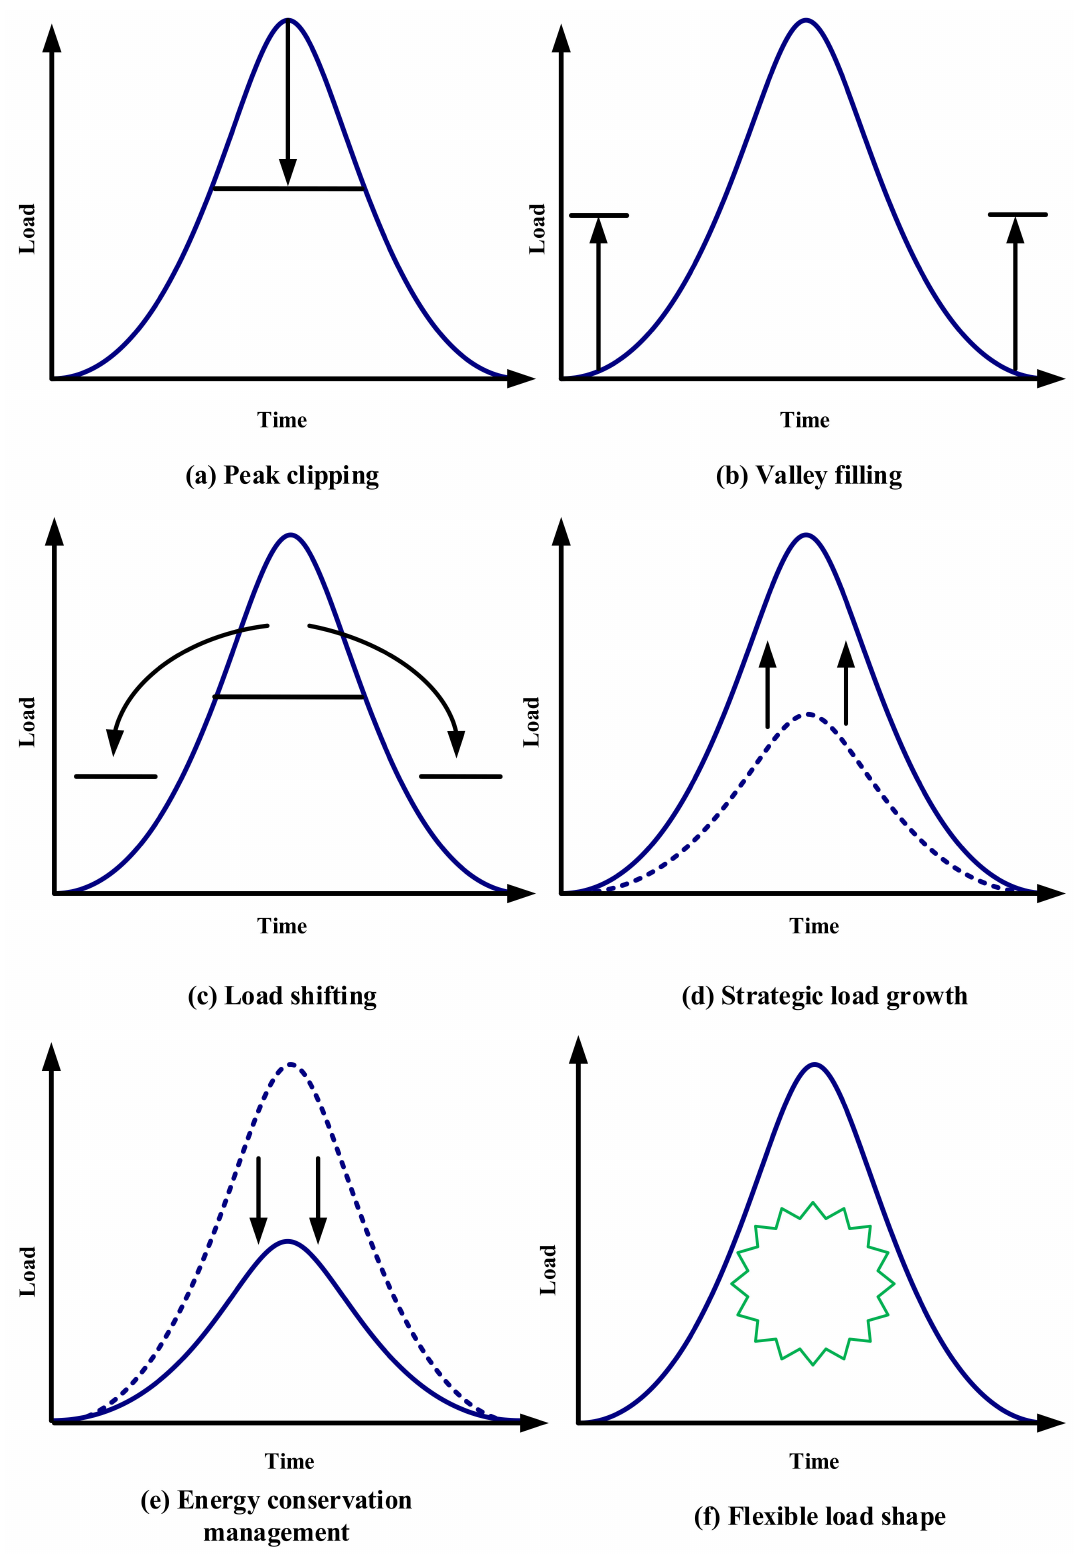
Figure 1. All types of demand-side